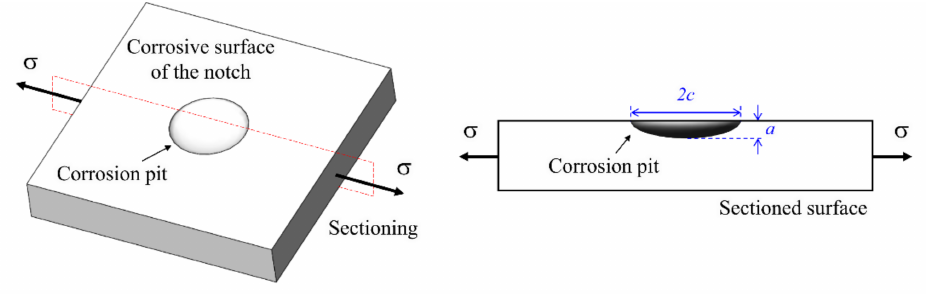
Figure 6. Schematic illustration of pit